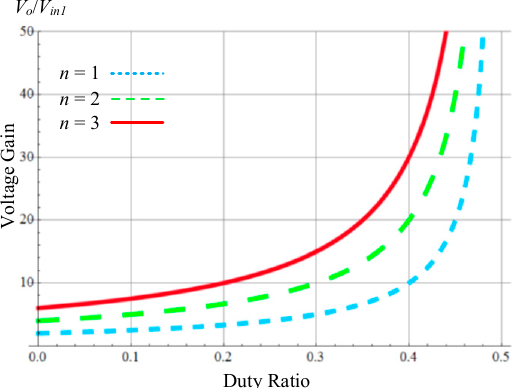
Figure 8. The voltage gain versus duty ratio under the SIO situation.